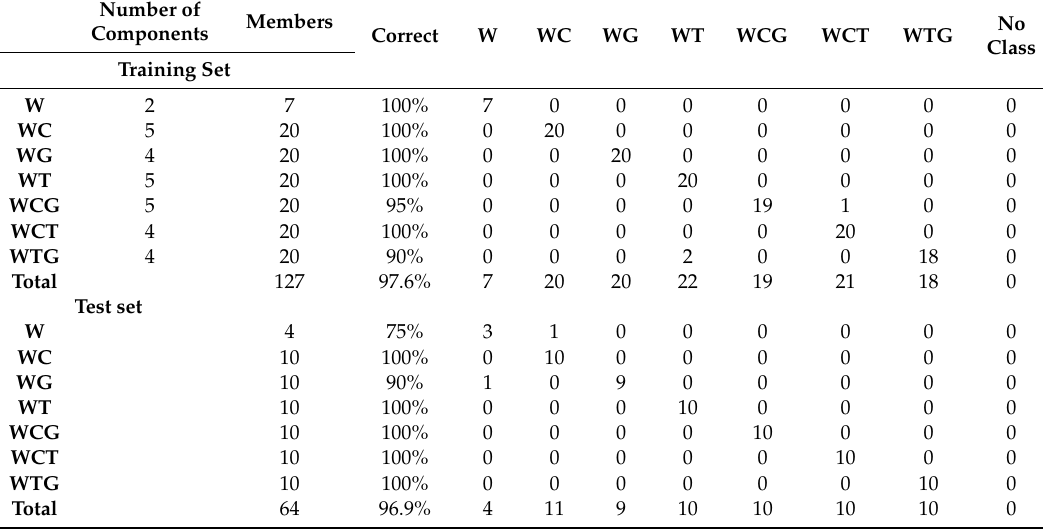
Table 1. Classification prediction results and number of components of soft independent modeling class analogy (SIMCA) model with 500–1100 cm − 1 spectral regions.